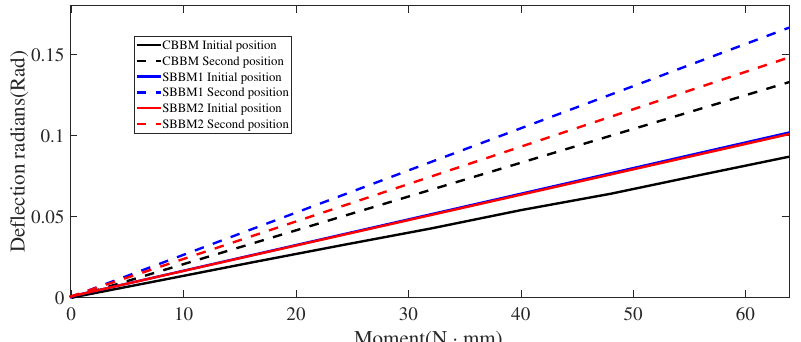
Figure 17. Experimental curve of moment and deflection radians of bistable mechanisms.